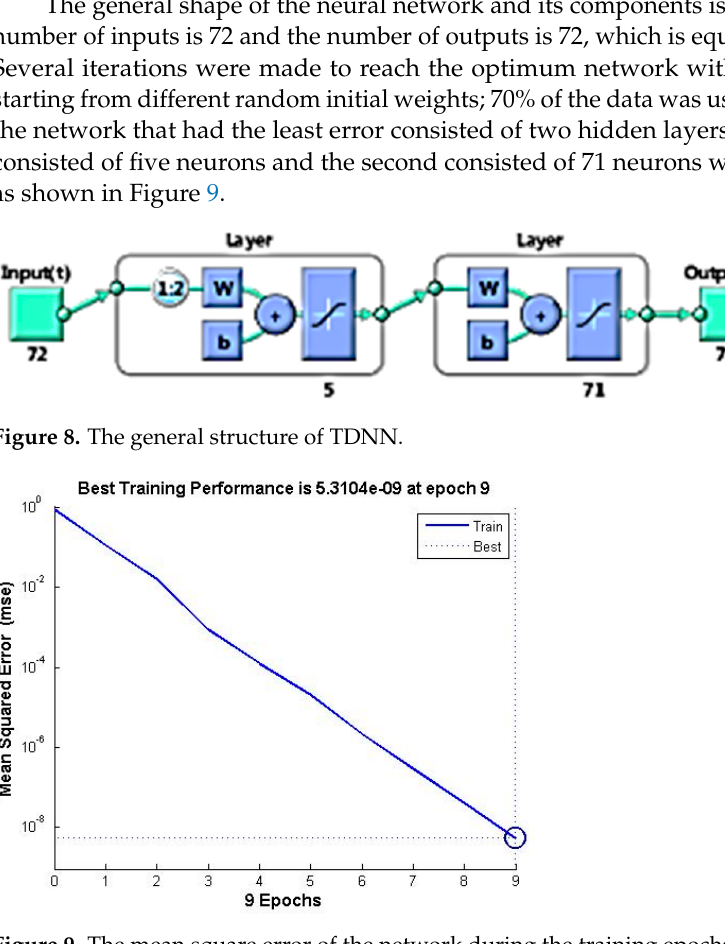
Figure 9. The mean square error of the network during the training epochs.